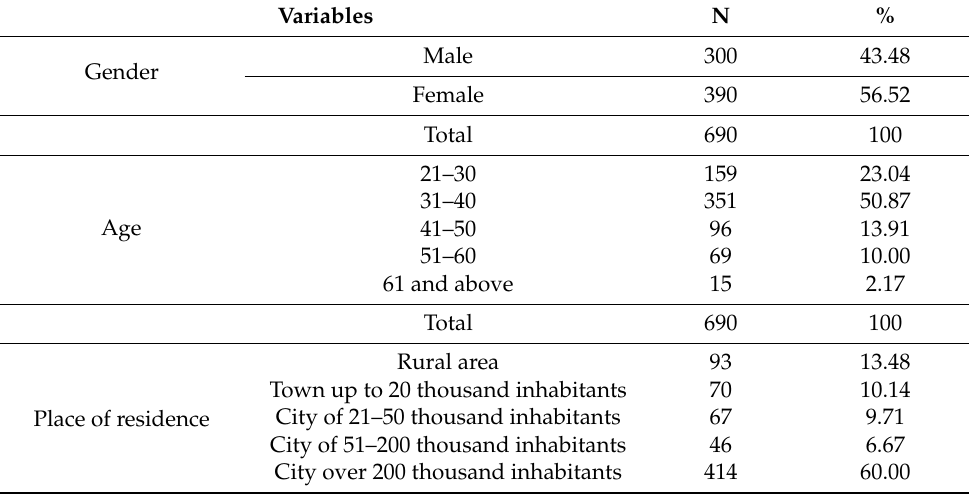
Table 1. Sociodemographic variables of the research